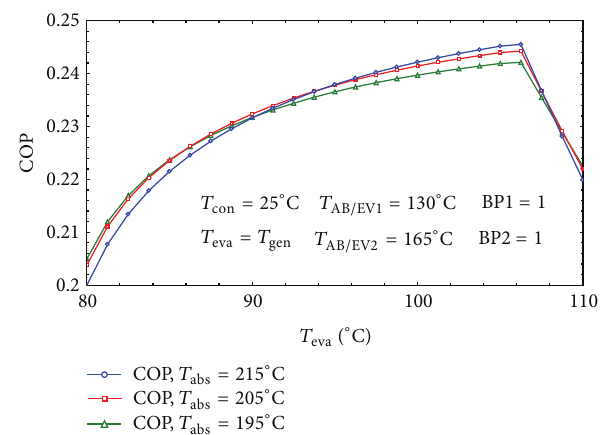
Figure 4: Effect of 𝑇